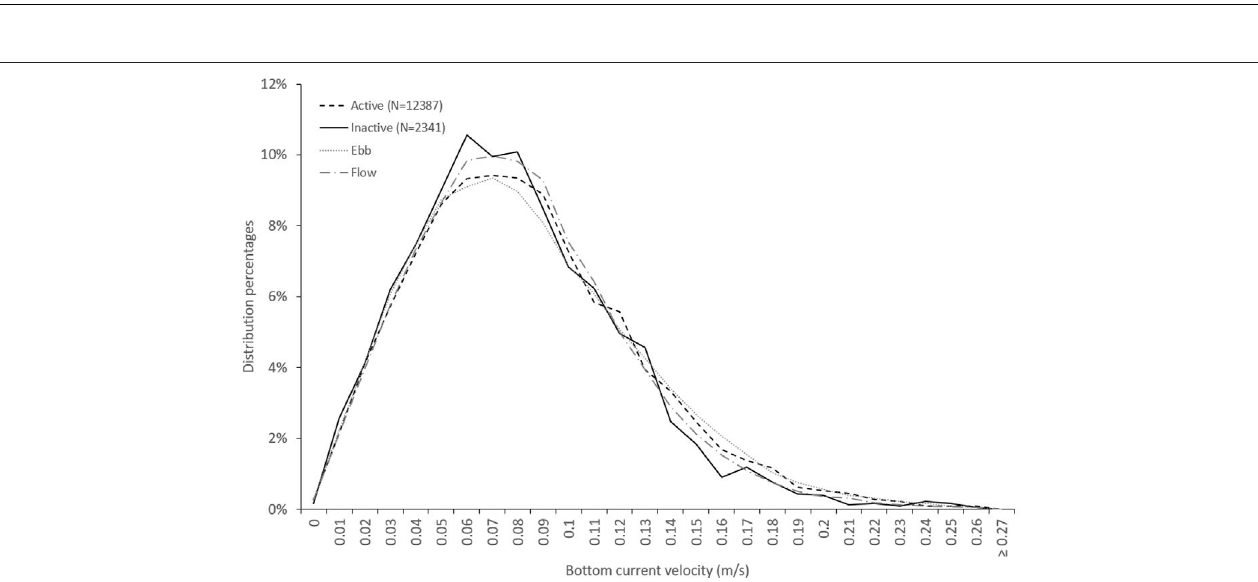
FIGURE6| Distributionofbottomcurrentspeedsatwaterdepthsfrom1,234 mto1,242 mduringactiveandinactivegasemissionsandduringebband fl owtides.